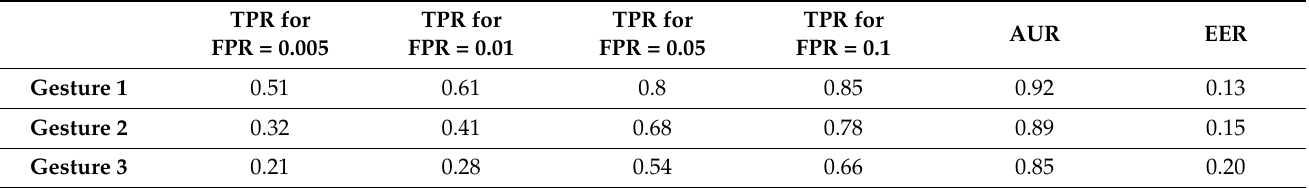
Figure 9. ROC curves in case of 30 min delay (Short-Time Delay) and 4-day delays (Long-Time Delay) between training and testing acquisitions. Table 1. Performance comparison (TPR, AUR and EER) for the three considered gestures.